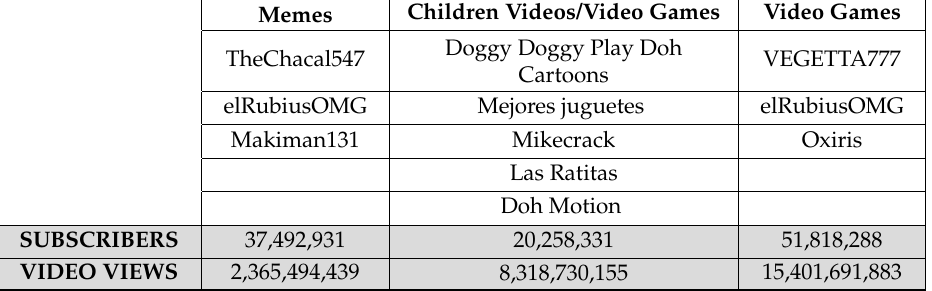
Table 1. Subgenres inside the entertainment SB genre in top 10 Spanish YouTubers (5 May